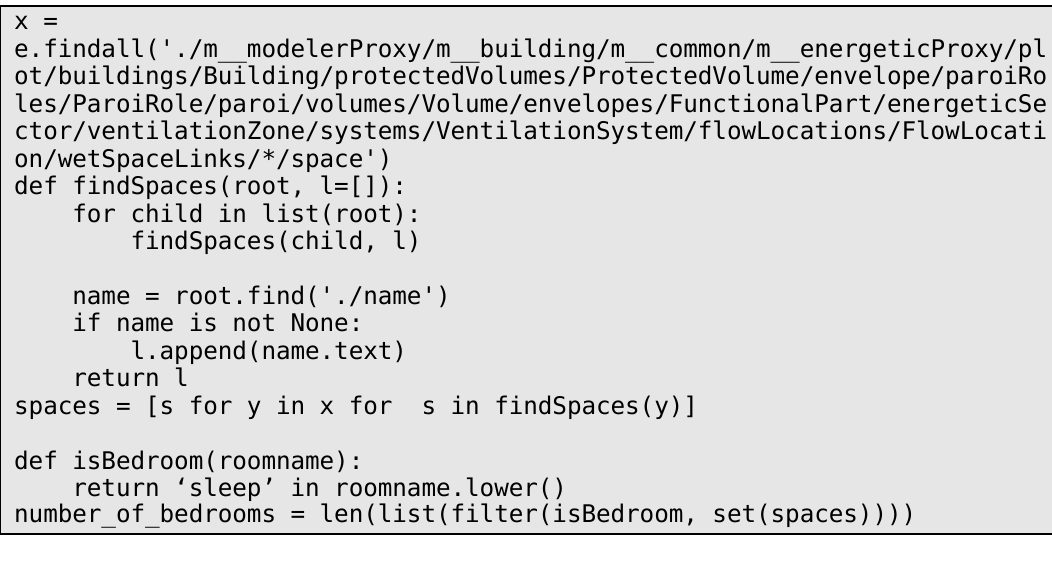
Figure 5. Code segment of Python extraction script to define the existing rooms (e.g., number of bedrooms).